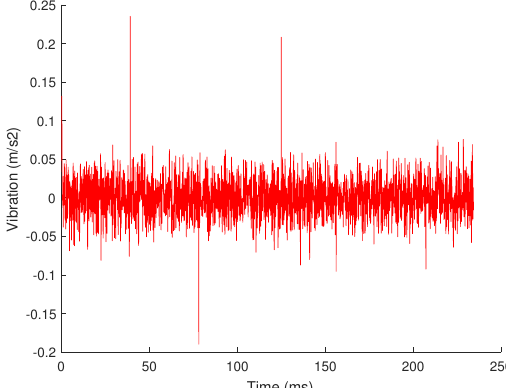
Figure 10. The residual signal obtained after the four-level